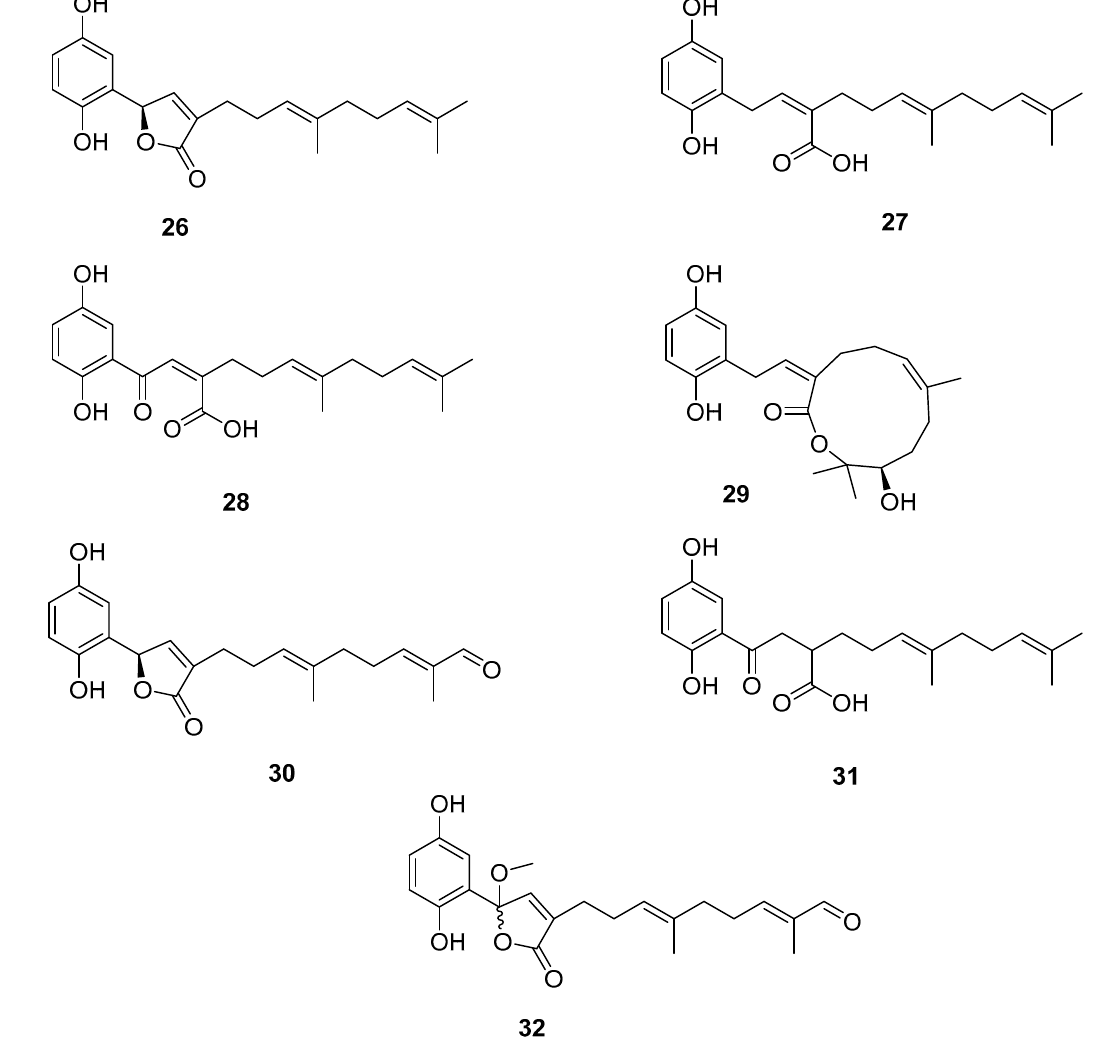
Figure 6. The meroterpenes from Ganoderma leucocontextum.